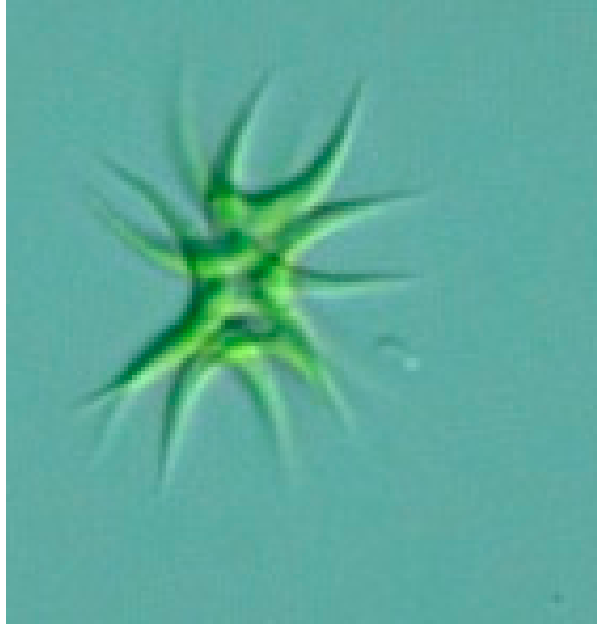
Figure 1. Light microscopy of Selenastrum sp. [21] .